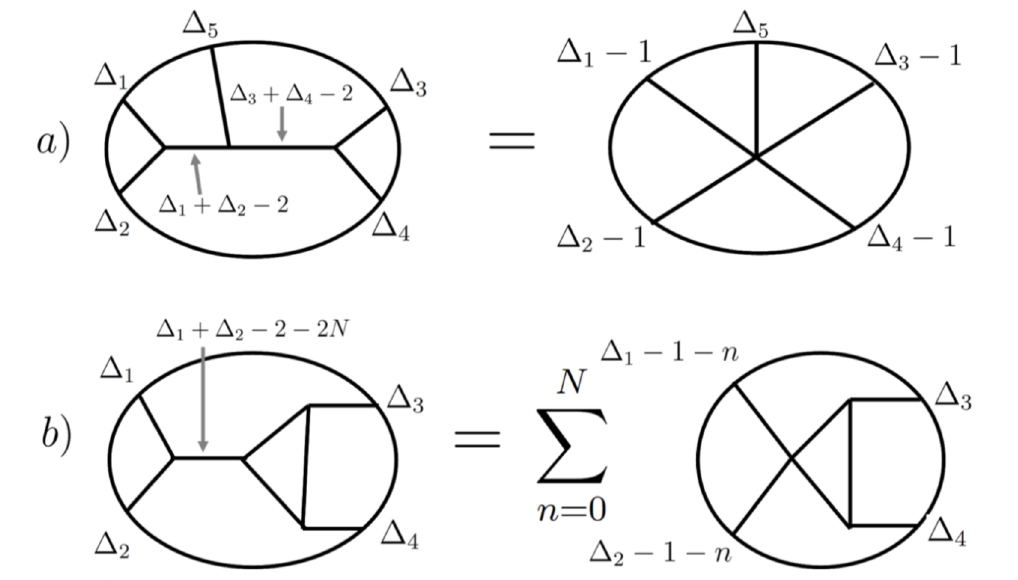
Figure 6 . Applications of Identities 3 and 3’. a) An example of a 5-point exchange diagram which equals the 5-point contact diagram on the right. b) Identity 3’ applied to 4-point triangle diagram. We are suppressing numerical coe(cid:14)cients in these